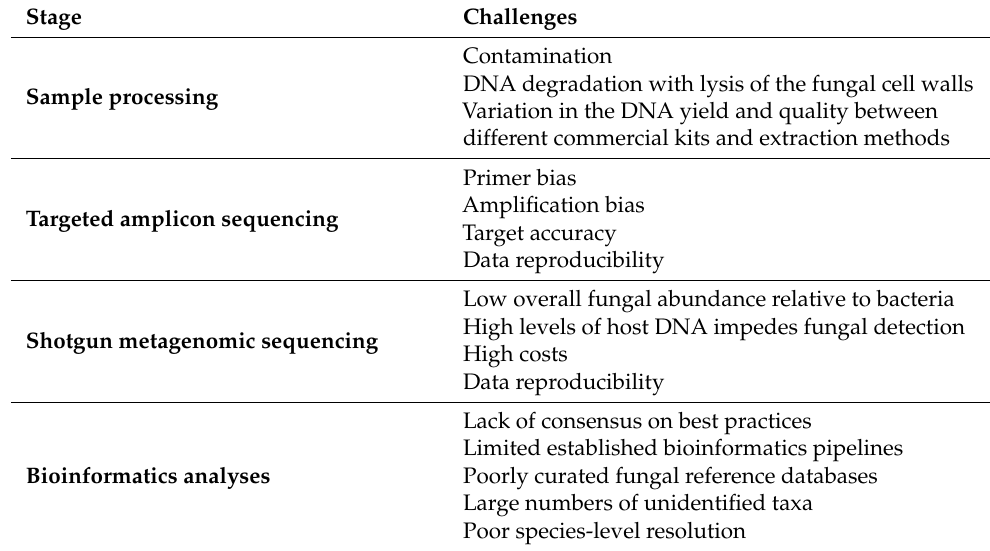
Table 1. Challenges in next-generation sequencing of the